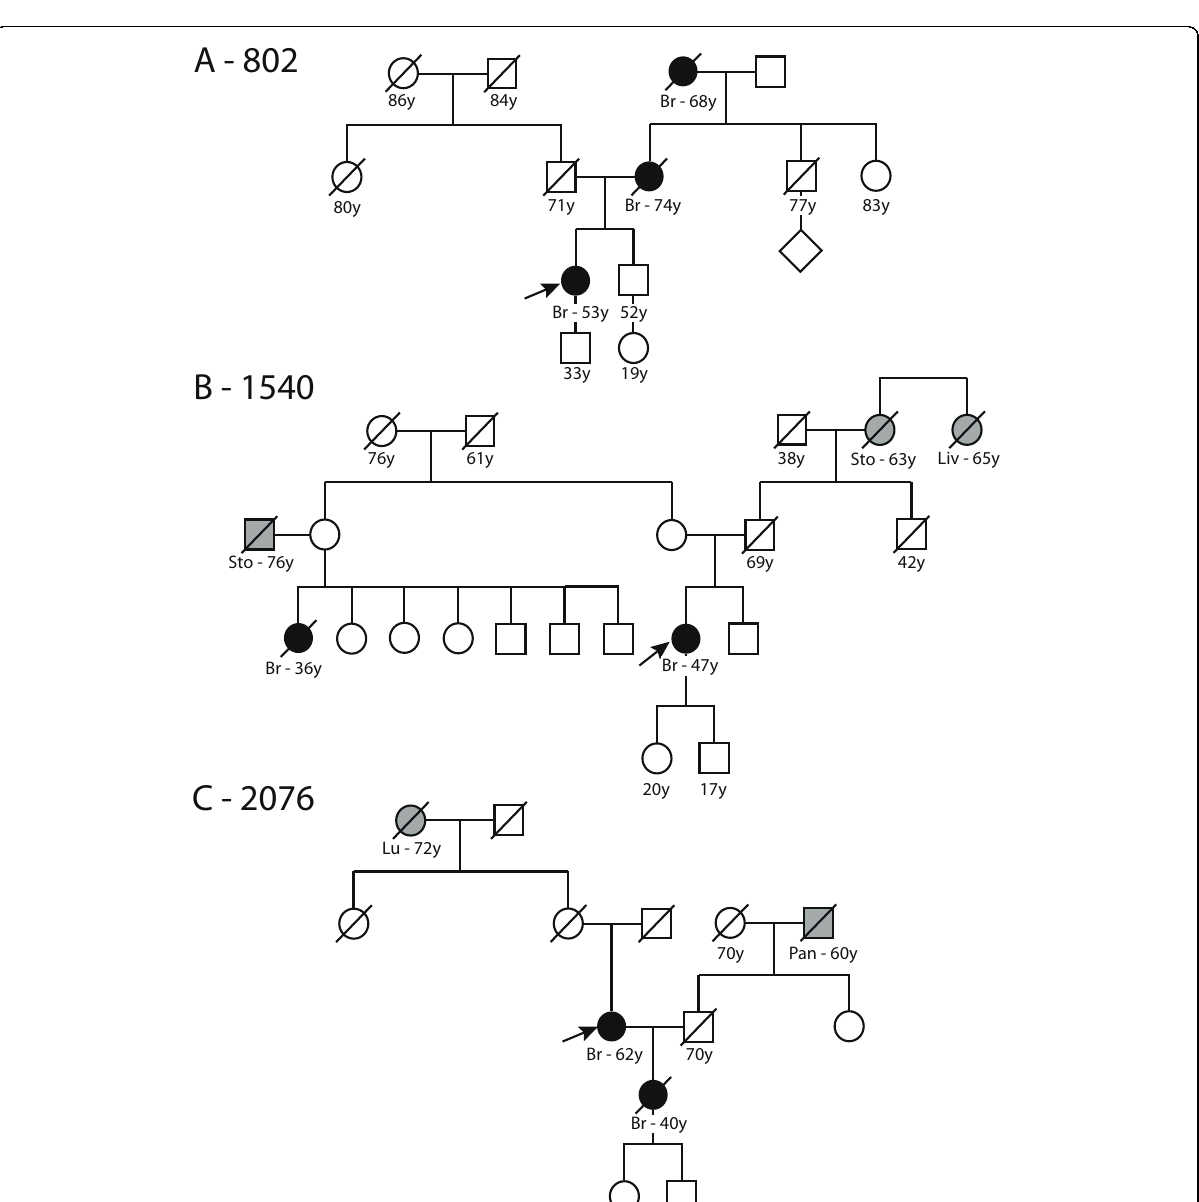
Figure 2 Pedigrees of breast cancer families with PALB2 mutations . Probands with confirmed mutation are indicated by an arrow. Br -breast cancer, Sto -stomach cancer, Liv -liver cancer, Lu - lung cancer, Pan - pancreatic